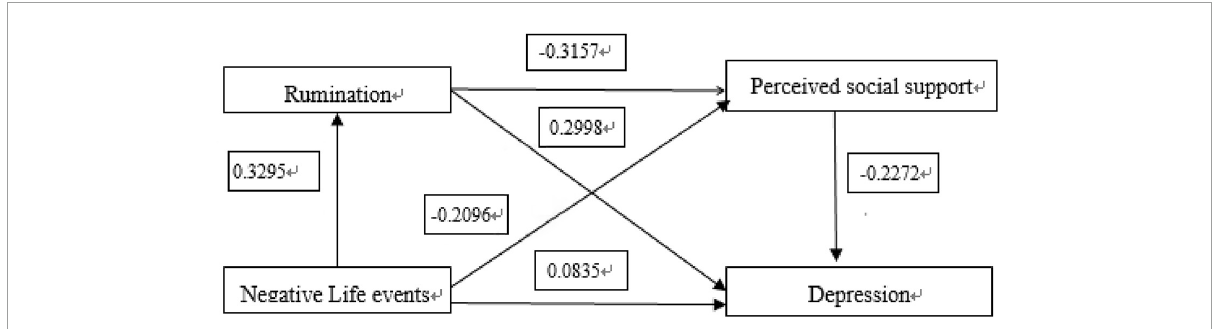
FIGURE1 Ruminating and perceiving social support influences in the chain-mediated model of the relationship between negative life events and depression.